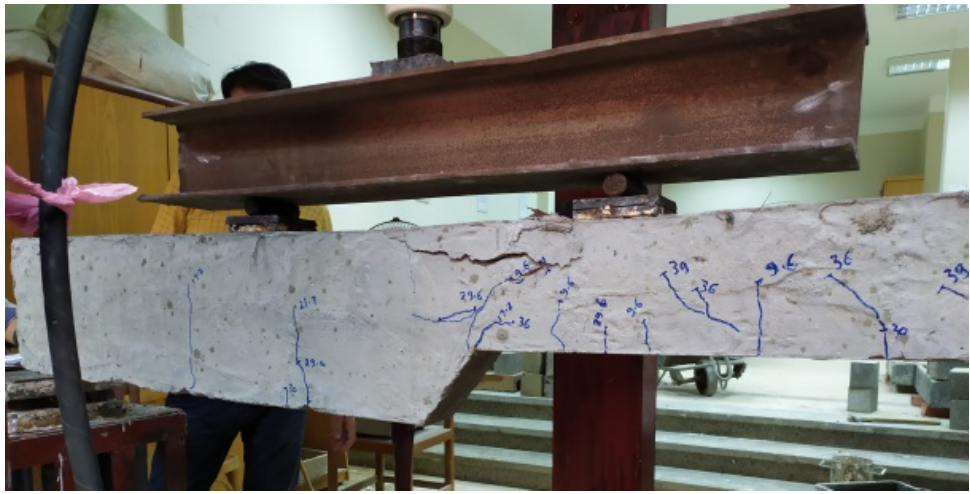
Figure 18. Crack pattern of beam B6.